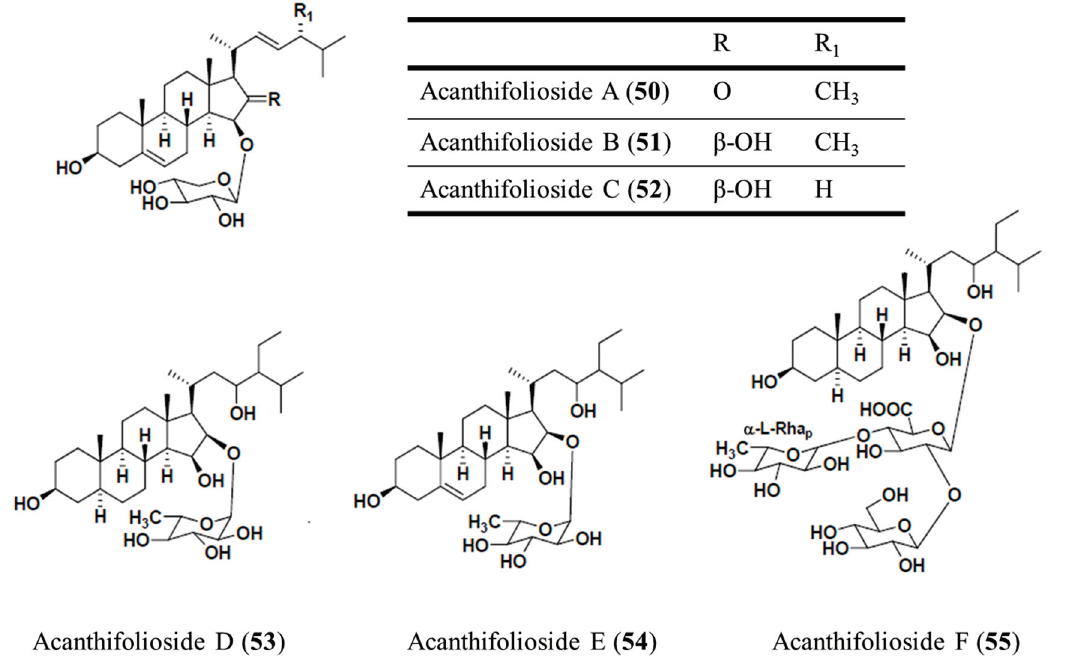
Figure 11. Acanthifoliosides A–F ( 50 – 52 ) isolated from the sponge, Pandaros acanthifolium